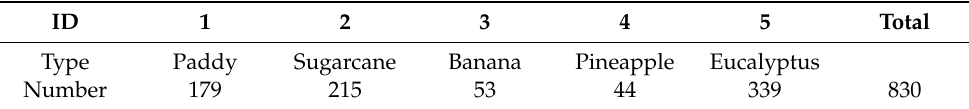
Table 1. Number of samples per